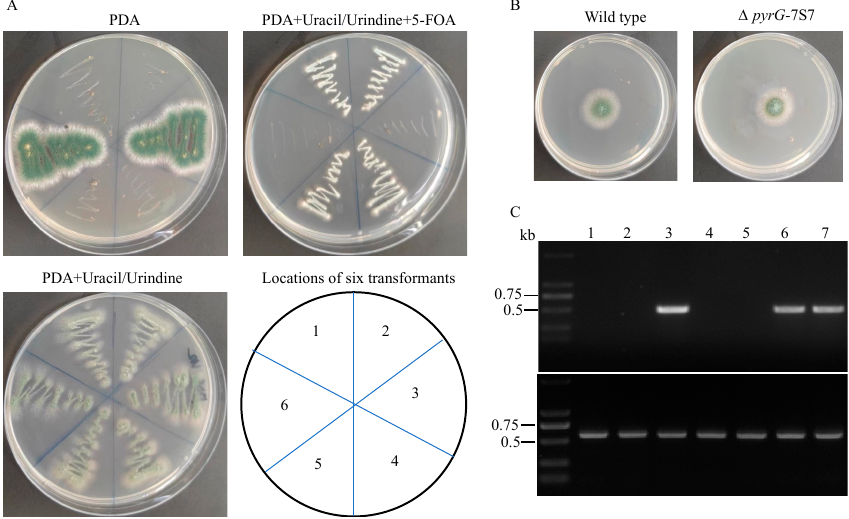
Figure 2. The inactivation of the pyrG ‐ 7S7 gene in Aspergillus sp. SCSIO SX7S7 using the CRISPR ‐ Cas9 system. ( A ) Growth of the transformants carrying the CRISPR ‐ Cas9 plasmids containing a sgRNA targeting exon of pyrG ‐ 7S7 on a PDA medium with or without uridine ‐ uracil (5 mM) and a PDA medium supplemented with both uridine/uracil (5 mM) and 5 ‐ FOA (1 mg/mL). ( B ) Growth of the Aspergillus sp. SCSIO SX7S7 wild type and ∆ pyrG ‐ 7S7 strains on a PDA medium with uridine/uracil (5 mM) at 28 °C for 4 days. ( C ) DNA was extracted from the six randomly selected transformants (shown on the left side) and amplified by PCR using the primers flanking the PAM site (upper panel), and the DNA template quality of the tested samples was validated using primers flanking the ITS region (lower panel). PCR amplification with the same primers of DNA from the wild type strain served as positive control. (Lane 1–6: tested transformants; lane 7: wild ‐ type strain.).